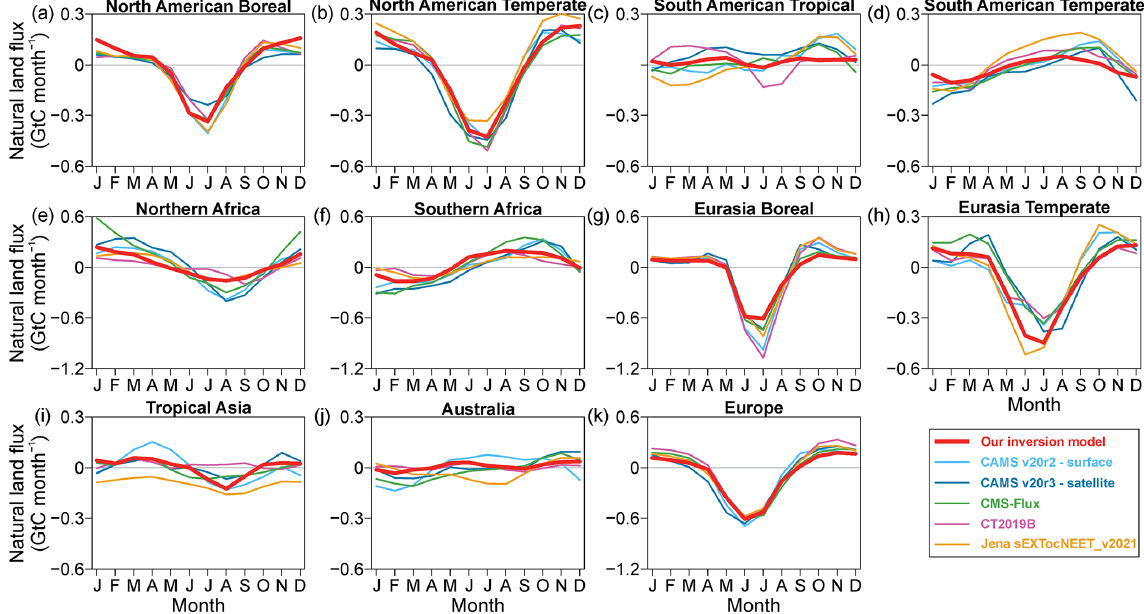
Figure 7. Seasonal cycle amplitudes of the natural land fluxes derived over the 11 TransCom land regions from 2015 to 2018. Each atmo- spheric inversion is represented by a solid curve representing the posterior natural land flux (i.e., terrestrial biospheric + fire fluxes) averaged between 2015 and 2018; the colors are the same as those shown in Fig. 3. The references for each inversion model are listed in the caption of Fig. 3.